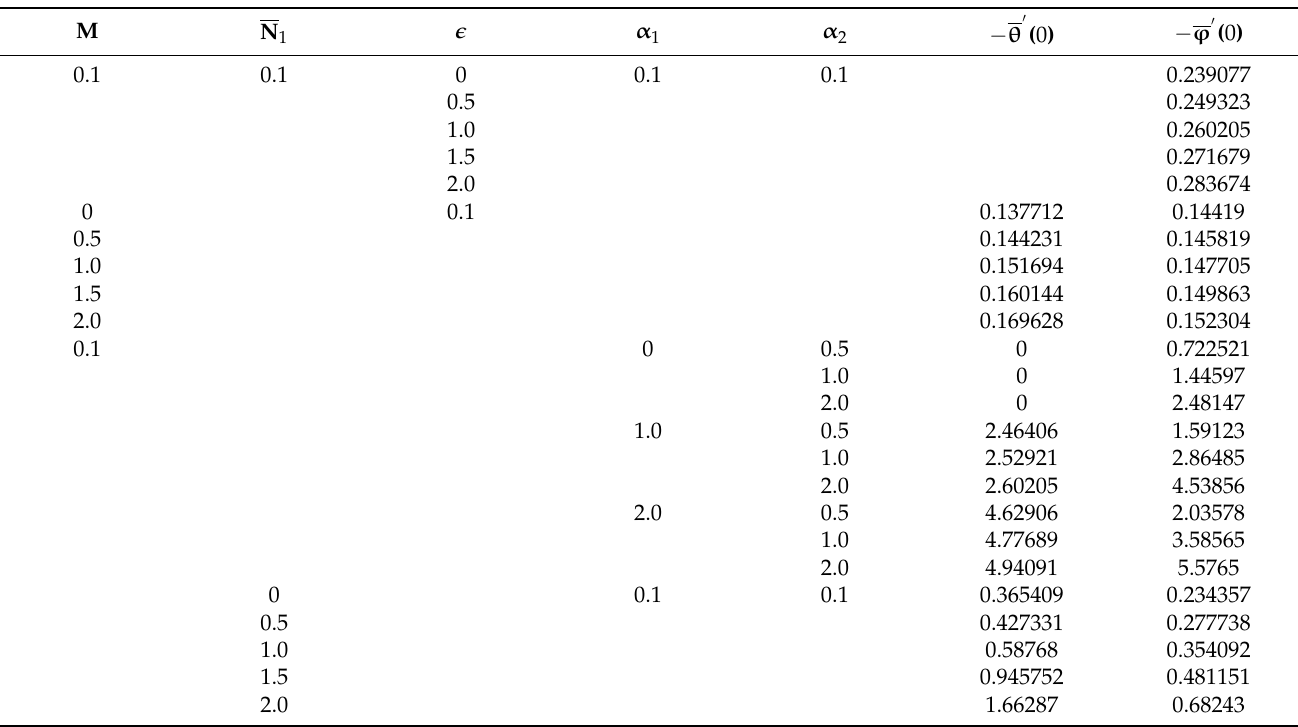
Table 7. Computed values of heat transfer rate and mass transfer rate for different values of magnetic parameter Figure 19. Temperature and concentration profiles for variant N̅ b .